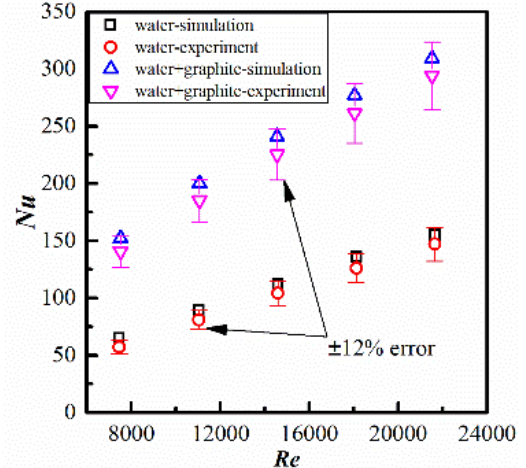
Figure 12. Comparison of the simulation and experiment.